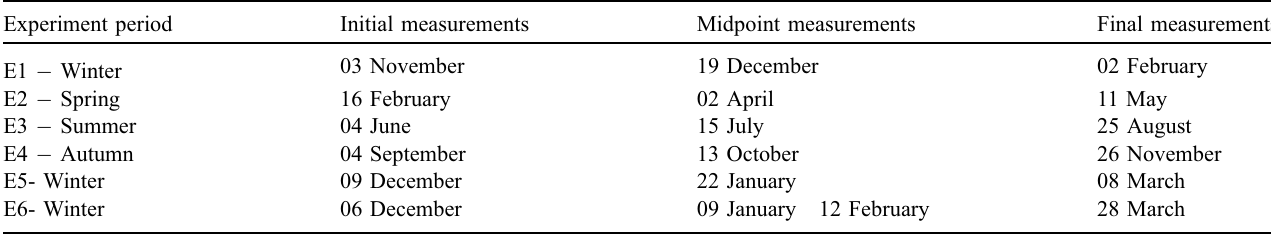
Table 1. Testing periods and measurement schedule.